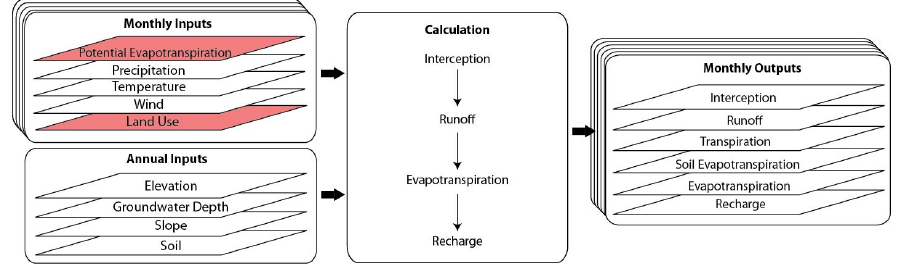
Figure 2. Schematic representation of WetSpass-M inputs and outputs. Data sets shown in red were adjusted to account for burning scenarios.